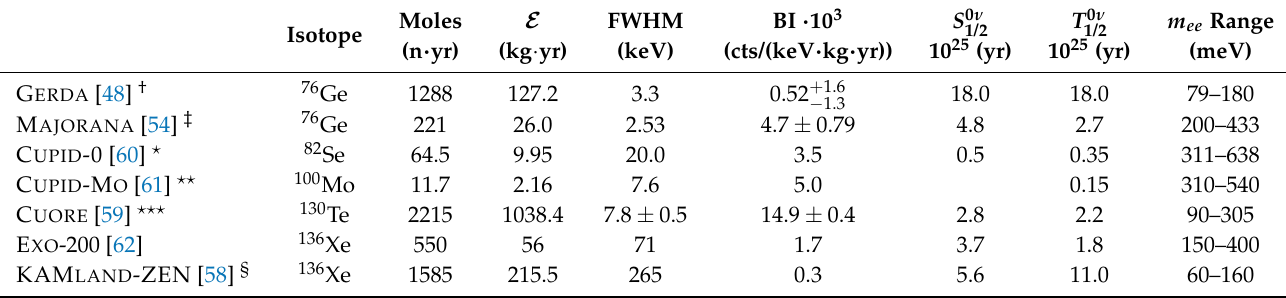
Table 6. Comparison of the main facts and results of the latest double beta decay experimental searches. M AJORANA , C UPID -0 and C UPID -M O are demonstrators of the M AJORANA and C UPID technology,